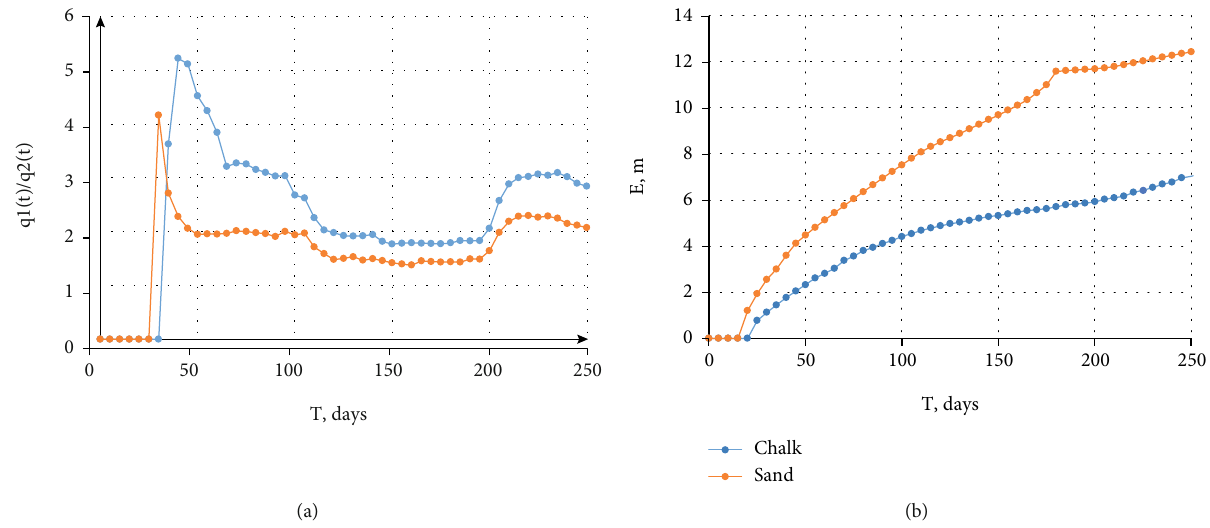
Figure 9: Time charts of the heat out fl ow and heat in fl ow ratio at the FW boundary (a) and FW thickness (b) (shaft no. 1).